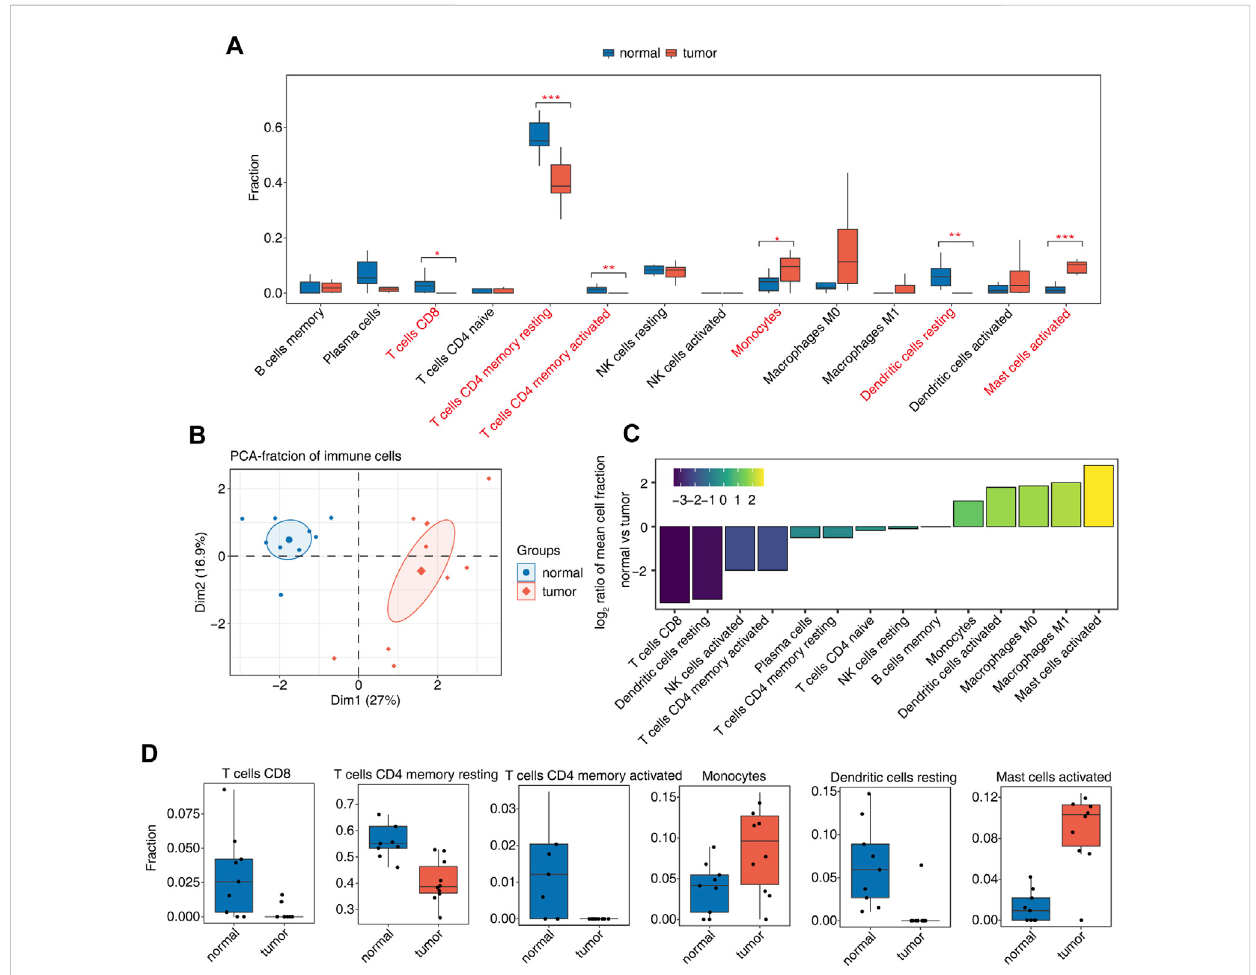
FIGURE 2 Diversity of immune microenvironment characteristics between tumor and normal samples from osteosarcoma patients. (A) Boxplot showing the fractionofeachcelltypeineachgroup. Thesigni fi cantdifferenceintheimmunecellfractionsbetweentumorandnormal sampleswascalculatedbythe Student ’ sttest.*, p -value ≤ 0.05;**, p -value ≤ 0.01;***, p -value ≤ 0.001. (B) Principalcomponent analysis (PCA)basedonthefractions ofdifferentcellsof all expressed genes. The ellipse for each group is the con fi dence ellipse. (C) Tumor relative to the normal group rank ordered based on decreasing values of the relative frequency ratio at tumor versus normal groups. (D) Boxplot showing six signi fi cantly immune